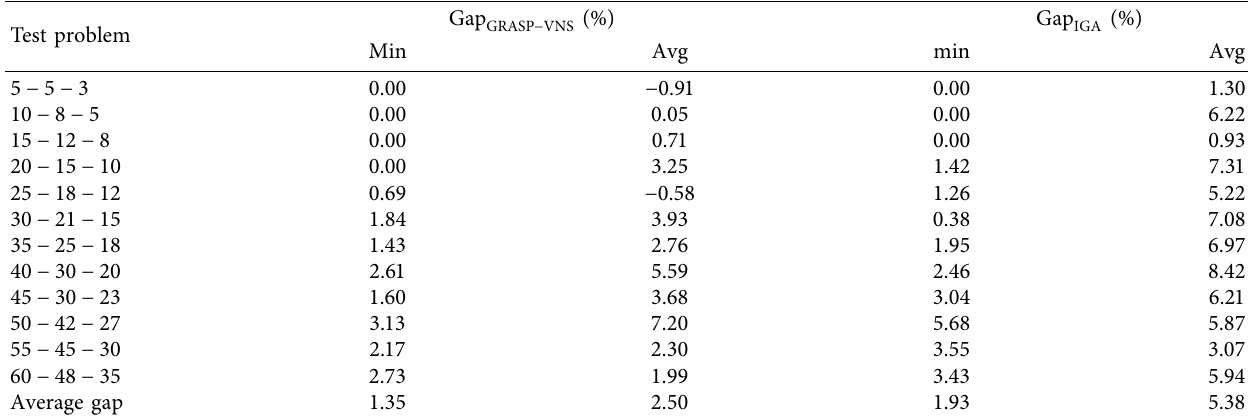
Table 8: Comparison with GRASP-VNS and